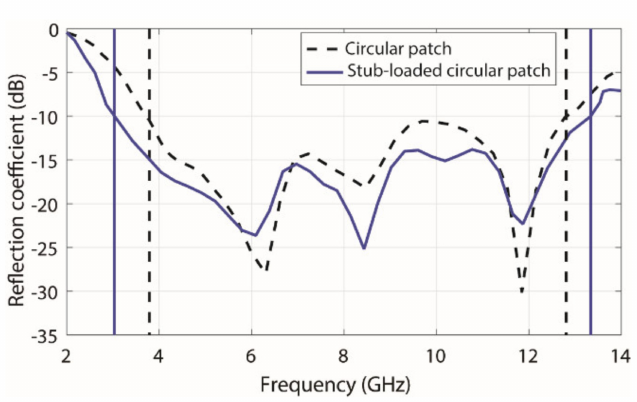
Figure 2. S 11 of circular patch and stub-loaded circular patch.